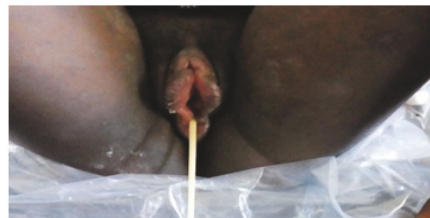
Figure 2: The vulvar edema in day 7, with urinary catheter.